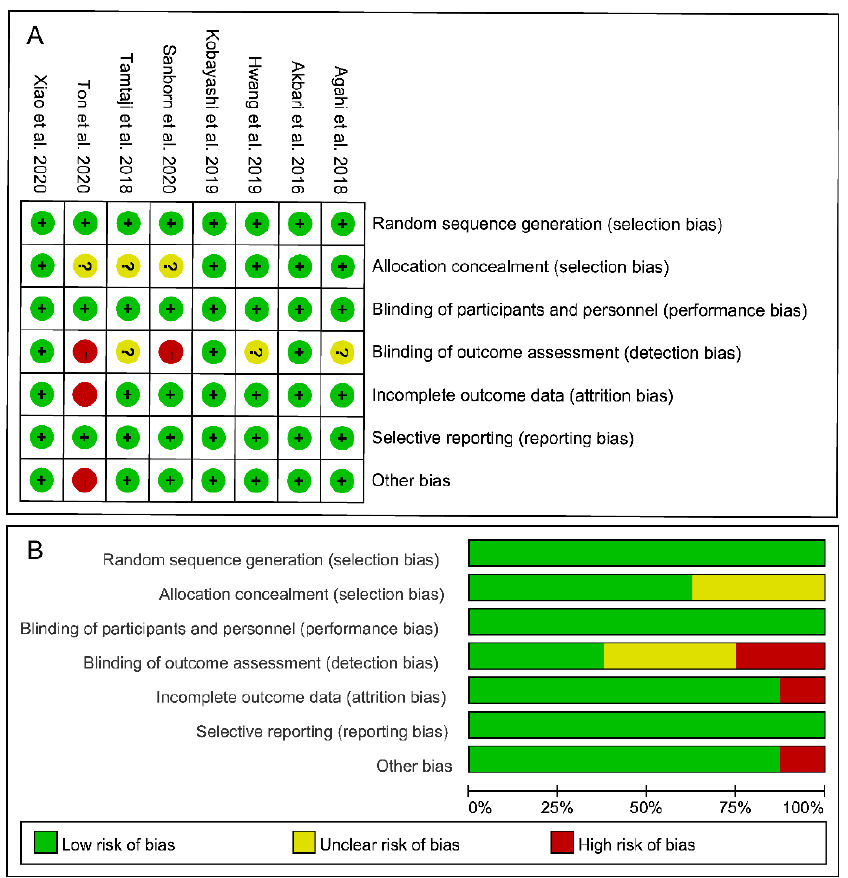
Figure 2. Risk of bias assessment for the included studies. ( A ) Risk of bias summary. ( B ) Risk of bias graph. Note: “+”: low risk, “?”: unclear risk, “-”: high risk.